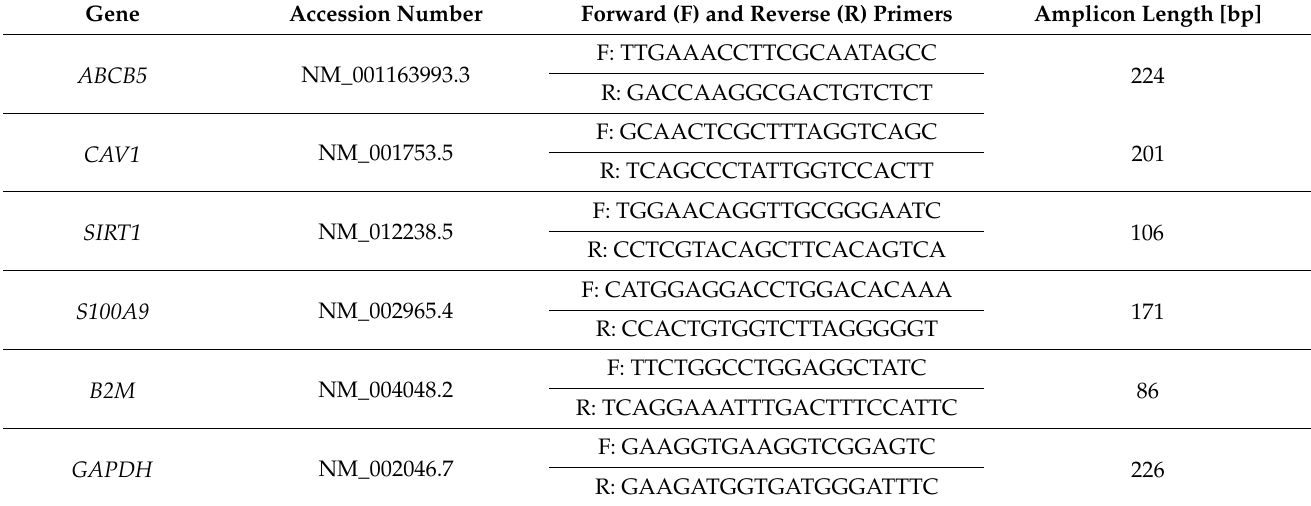
Table 4. Primer sequences, accession numbers and amplicon length of target genes and refer- ence